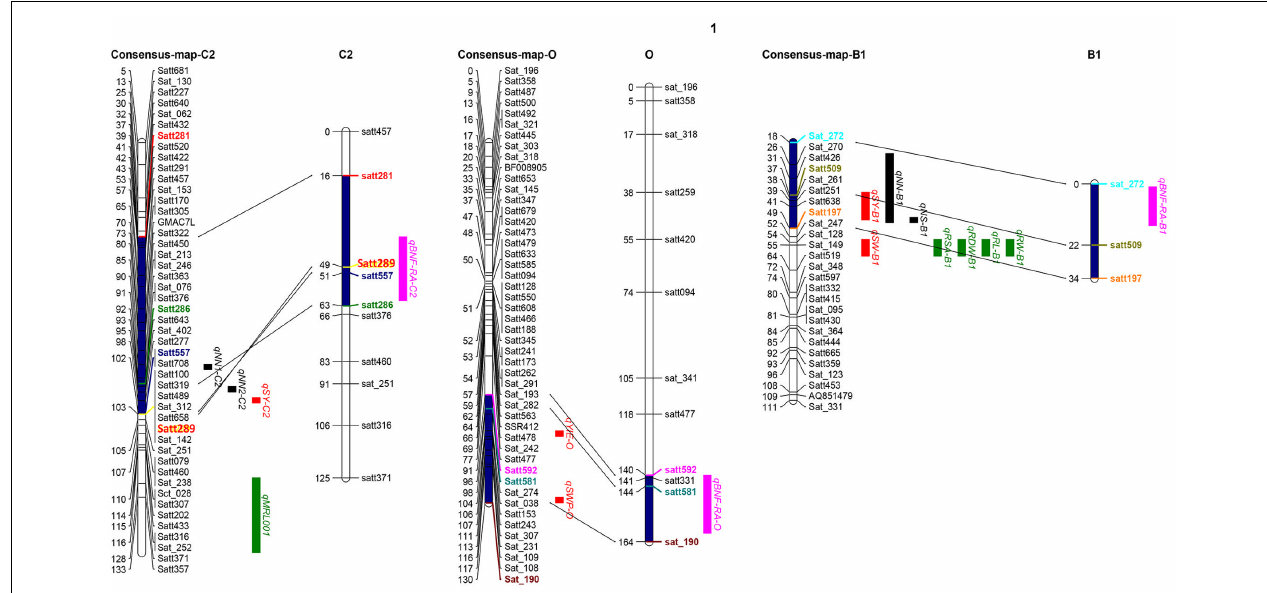
FIGURE 4 | Co-location analysis using three QTL clusters (pink) detected here, along with previously identified QTLs for yield (red), BNF (black) and RA (green) traits. Previously reported QTLs and references are showed as follows: qSY-C2 (Kabelka et al., 2004), qYIE- O (Wang et al., 2014), qSWP-O (Liu et al., 2011), qSW-B1 (Liang et al., 2010) and qSY-B1 (Du et al., 2009) for yield and SDW; qNN1-C2 (Hwang et al., 2014), qNN2-C2 (Hwang et al., 2014), qNN-B1 (Santos et al., 2013) and qNS-B1 (Hwang et al., 2014) for BNF traits; qRSA-B1 , qRDW-B1 , qRL-B1 , and qRW-B1 for RA traits (Liang et al., 2010). Projected regions are highlighted in dark blue. Markers in different colors indicate the corresponding markers on LGs and in projection